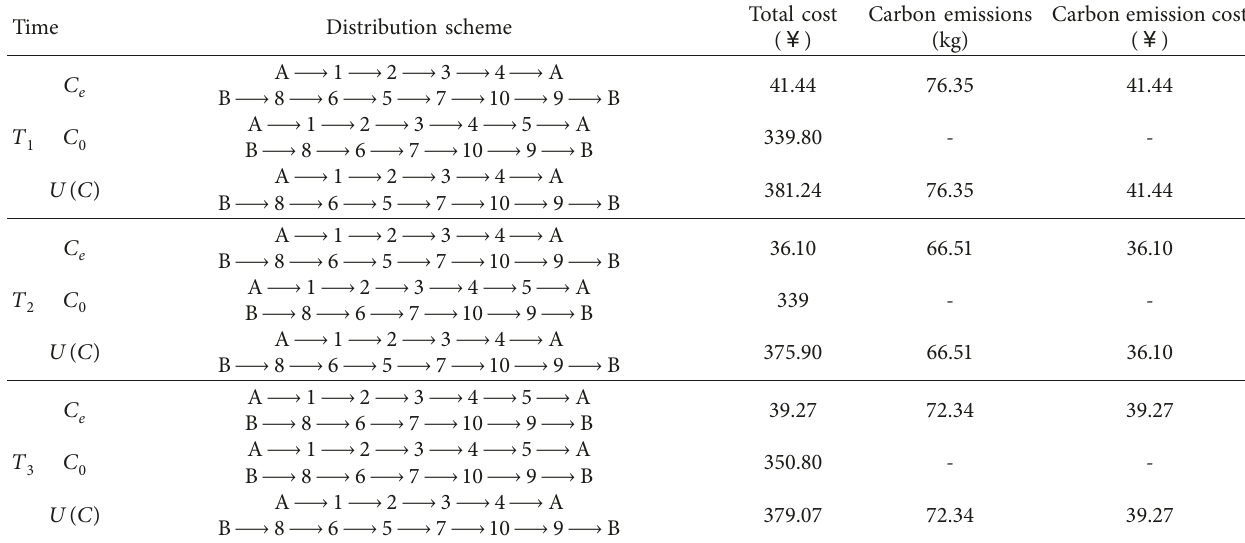
Table 6: Distribution scheme of single period time-varying network.